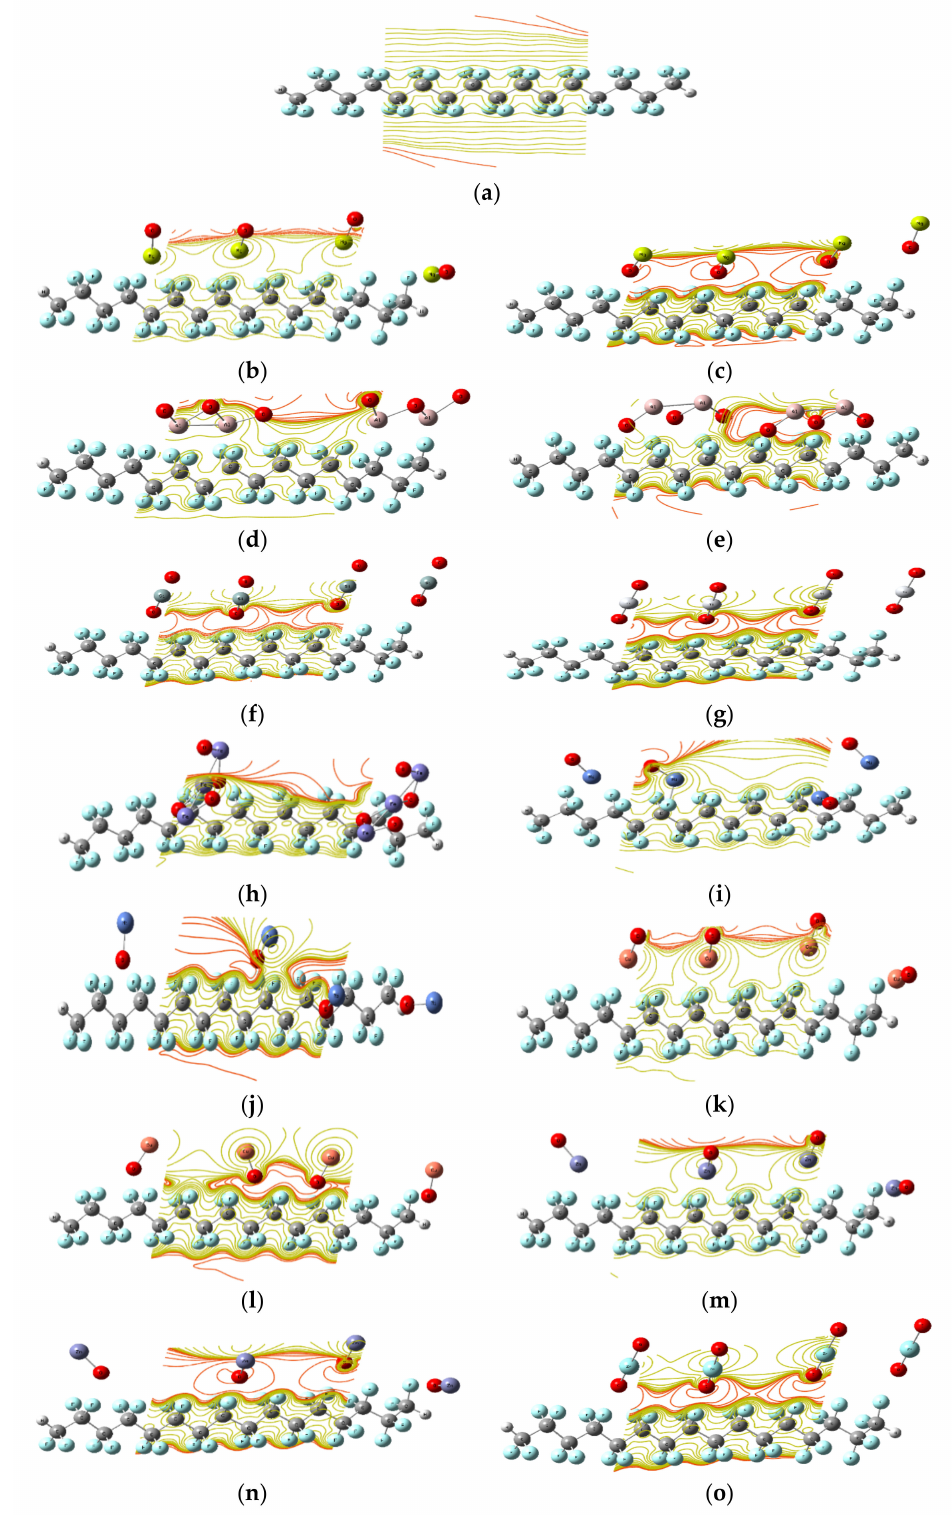
Figure 6. MESP mapping of PTFE interacting with different MOs using